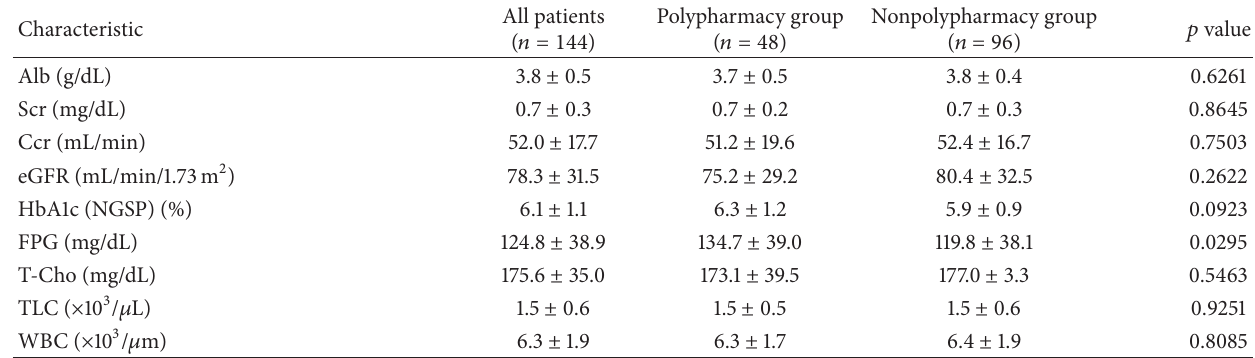
Table 3: Comparison of laboratory